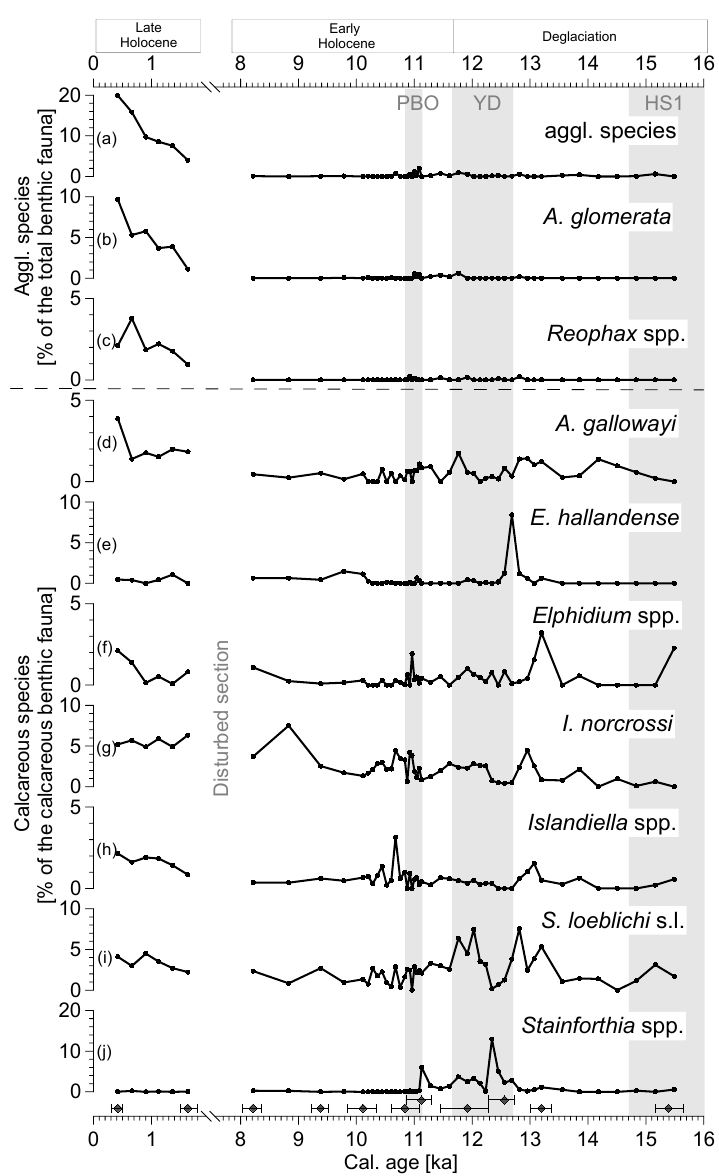
Figure A4. Relative percentages of the total benthic foraminiferal fauna: (a) sum of agglutinating species. (b) Adercotryma glomerata . (c) Reophax spp. Relative percentages of the calcareous benthic foraminiferal fauna: (d) Astrononion gallowayi , (e) Elphidium hallandense , (f) Elphidium spp. (excluding E. asklundi, E. bartletti, E. clavatum, E. hallandense ), (g) Islandiella norcrossi , (h) Islandiella spp. (exclud- ing I. helenae, I. islandica, I. norcrossi ), (i) Stainforthia loeblichi s.l. and (j) Stainforthia spp. (excluding S. loeblichi s.l.). Grey vertical shadings; see Fig. 4. Dark grey diamonds: calibrated radiocarbon ages with error ranges.